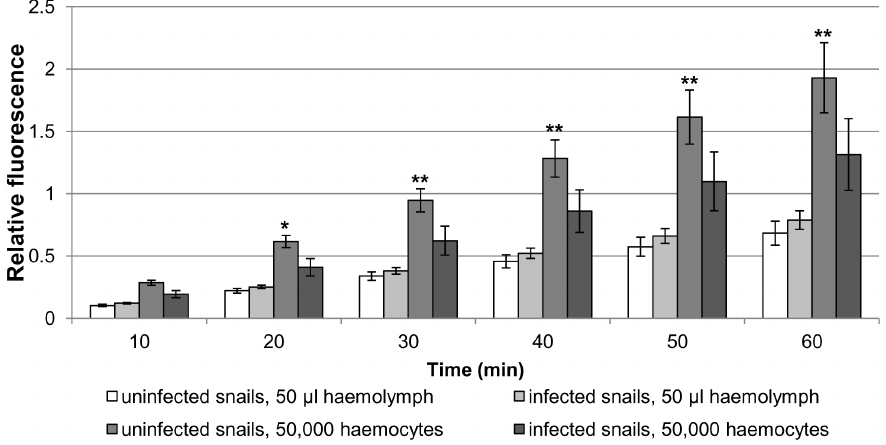
Figure 5. Basal H 2 O 2 production in haemocytes from uninfected and Trichobilharziaregenti infected Radixlagotis . H 2 O 2 output by haemocyte monolayers was detected by Amplex red and the intensity of fluorescence measured by microplate reader over 60 min. The mean relative fluorescence values are shown ( 6 SEM; n=7) and represent the increase in H 2 O 2 production over time. Data were evaluated per volume of haemolymph (50 m l) and per number of haemocytes (50,000). *p , 0.05, **p , 0.01, when compared to infected snails (50,000 haemocytes); two- sample t-test or Wilcoxon test combined with Fishers’s combination test.